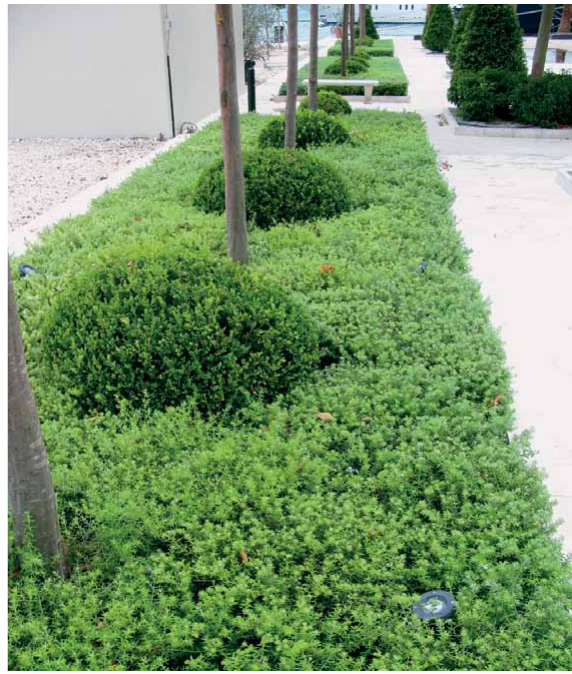
fig. 7. Hard and Soft landscaping fig. 8. Porto Montenegro